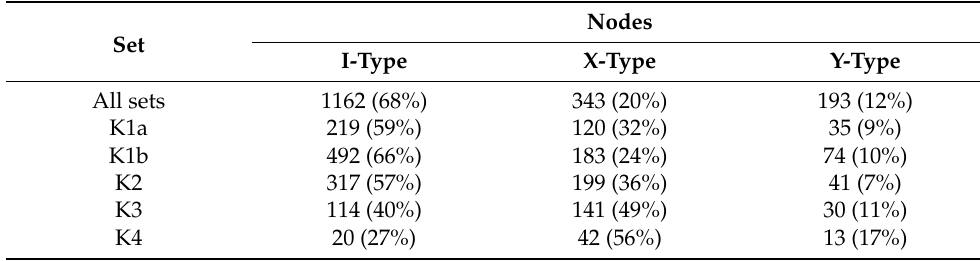
Figure 16. Ternary plots of the fracture termination nodes and branches defining the 2D fracture network topology for ( a ) Cassian Dolomite and ( b ) Heiligkreuz Formation. Pie ‐ charts representing ( c ) the proportion of Y ‐ type termination (fracture terminates on fracture) and ( d ) X ‐ type nodes of the fracture network topology of Cassian Dolomite. Table 3. Fracture nodes statistic retrieved from the topological analysis of the 2D fracture traces mapped onto the top of Lastoni di Formin Cassian Dolomite.